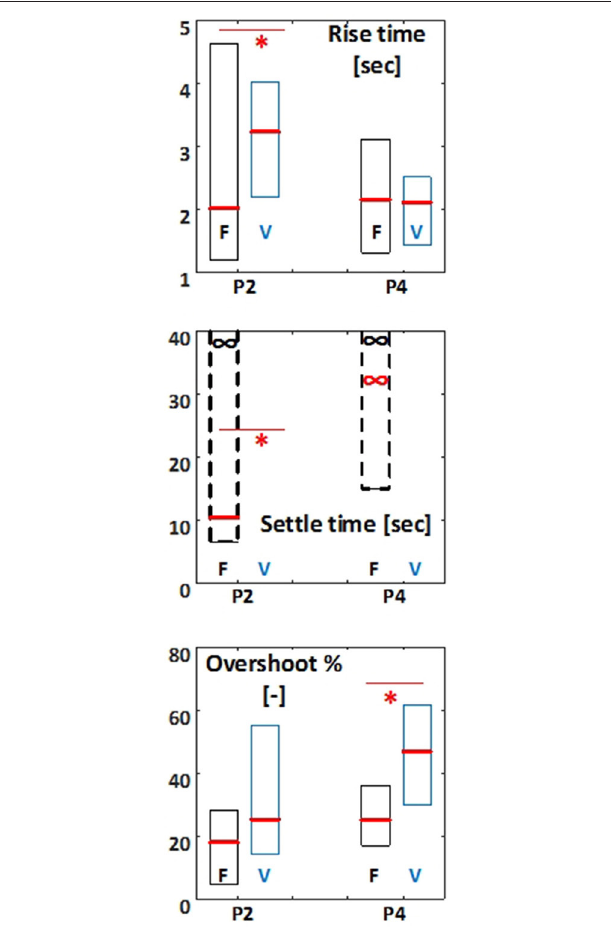
FIGURE 7 | Rise time (s), Settle time (s), and Overshoot (%) for test paradigm 2 (P2: standard weight) and paradigm 4 (P4: body weight). For each test the median parameter for the four steps is reported. F indicates FES controlled balance, and V indicates disrupted voluntary control of muscle contractions. The results are presented as box plot percentiles among all subjects. Boxplots related to FES condition are shown is black and those related to VOL condition are shown in blue. Asterisk indicates significant difference ( p < 0.05) between FES and VOL conditions. Red and black ( ∞ ) signs indicate the 50% and 75% percentiles, respectively, at